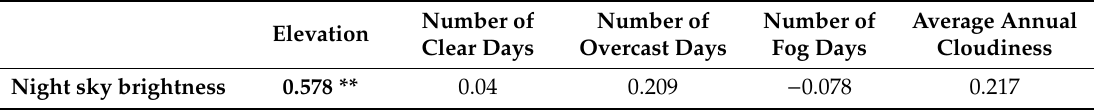
Spearman´s correlation coe ffi cients (n = 20) for night sky brightness and selected natural parameters. Number of Number of Number of Average Annual Elevation Clear Days Overcast Days Fog Days Cloudiness Night sky brightness 0.578 ** 0.04 0.209 − 0.078 0.217 ** Correlation is significant at the 0.01 level (in